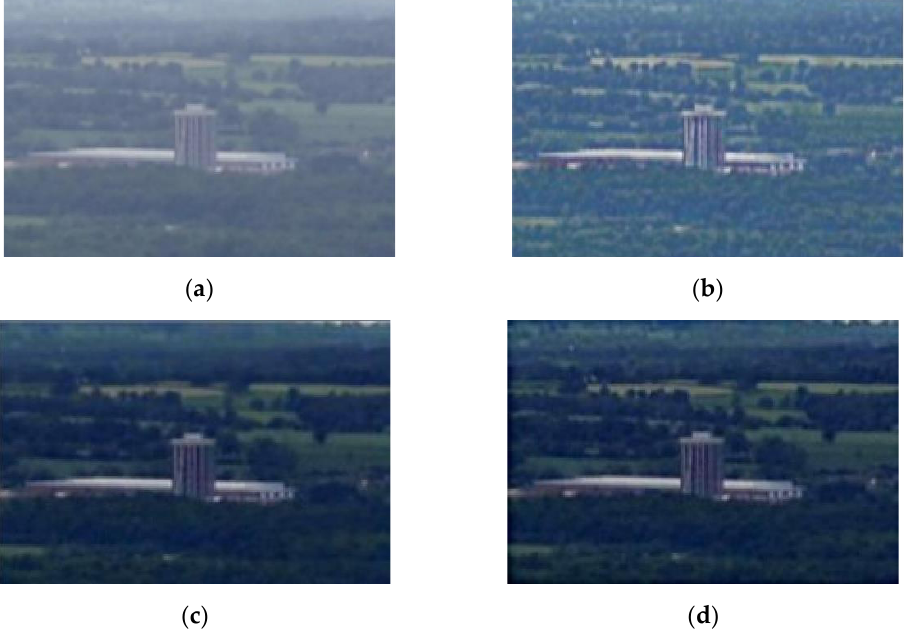
Figure 5. Detailed images of Figure 4: ( a ) original hazy image, ( b ) Tarel and Hautiere [35] method, ( c ) He et al. [40] method, and ( d ) proposed method.